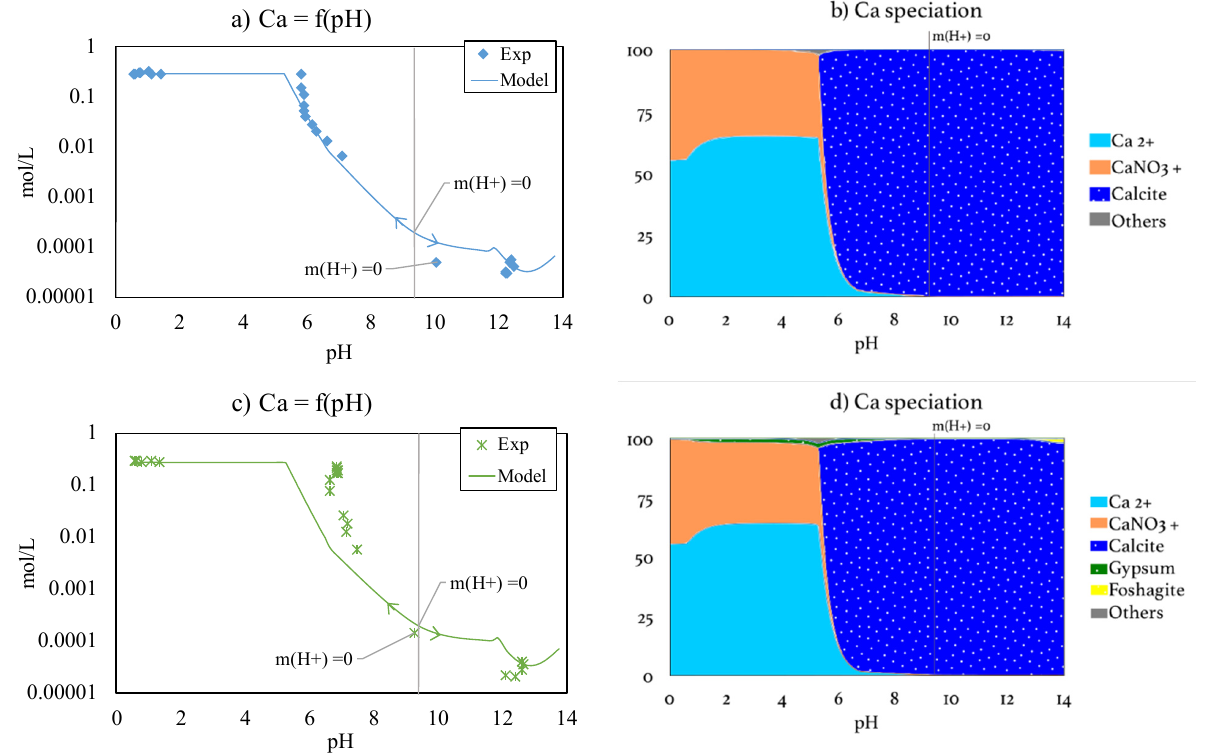
Figure 4. Total experimental soluble content and modeled speciation of calcium as a function of pH: ( a,b ) calcite/SiO 2 and ( c,d ) calcite/pyrite/SiO 2 . Arrows indicate the direction of addition or depletion of protons; the vertical line indicates the point of equilibrium with pure water (natural pH).